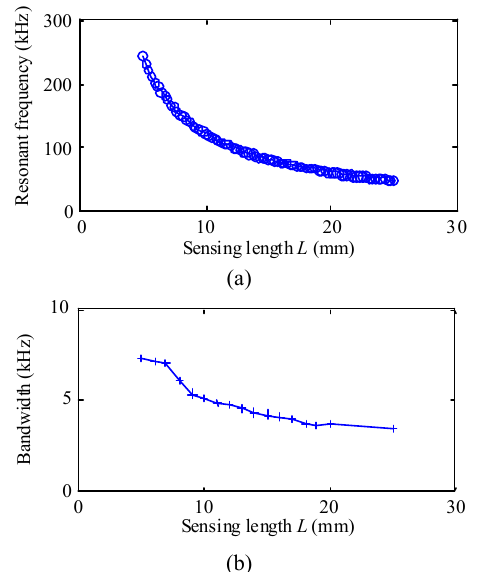
Fig. 3 Theoretical sensing characteristics of the designed sensor: (a) theoretical f 1 changes with L and (b) bandwidth of resonance peaks changes with L .